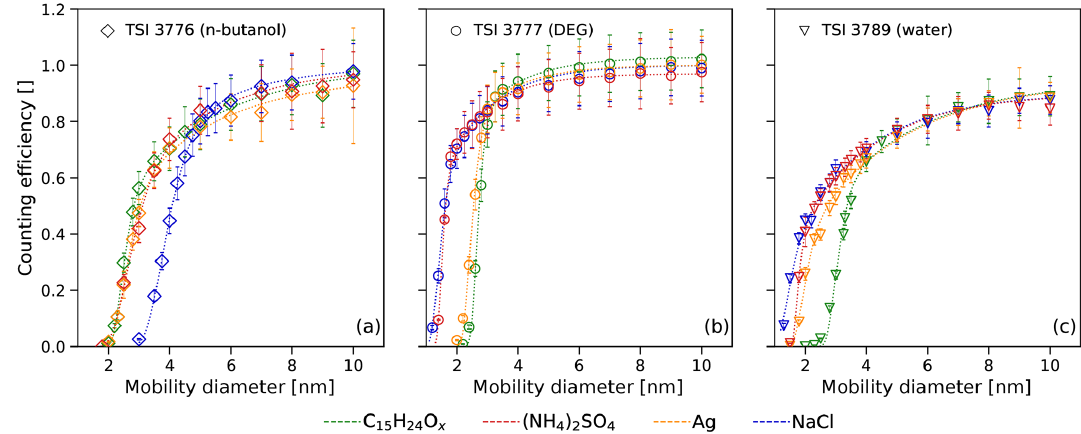
Figure 2. Detection efficiencies and working fluids: the figure shows the detection efficiencies for different seed particle materials as a function of the electrical mobility equivalent diameter. Different colors correspond to different seed particles, and every plot is related to a different working fluid: n -butanol (a) , DEG (b) and water (c) .